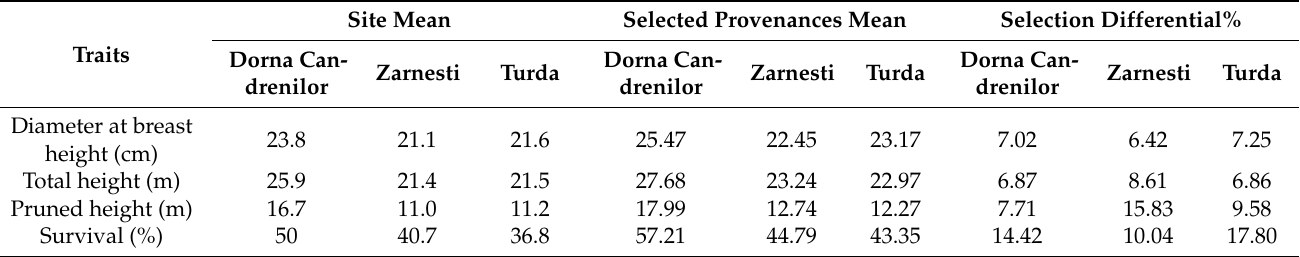
Figure 2. Norway spruce provenances ranking and selected provenances using the MTSI. The red line represents the selection intensity (15%). The dots represent the multi-trait stability index. Table 4. The selection differential of MTSI index for Norway spruce provenances at 48 years